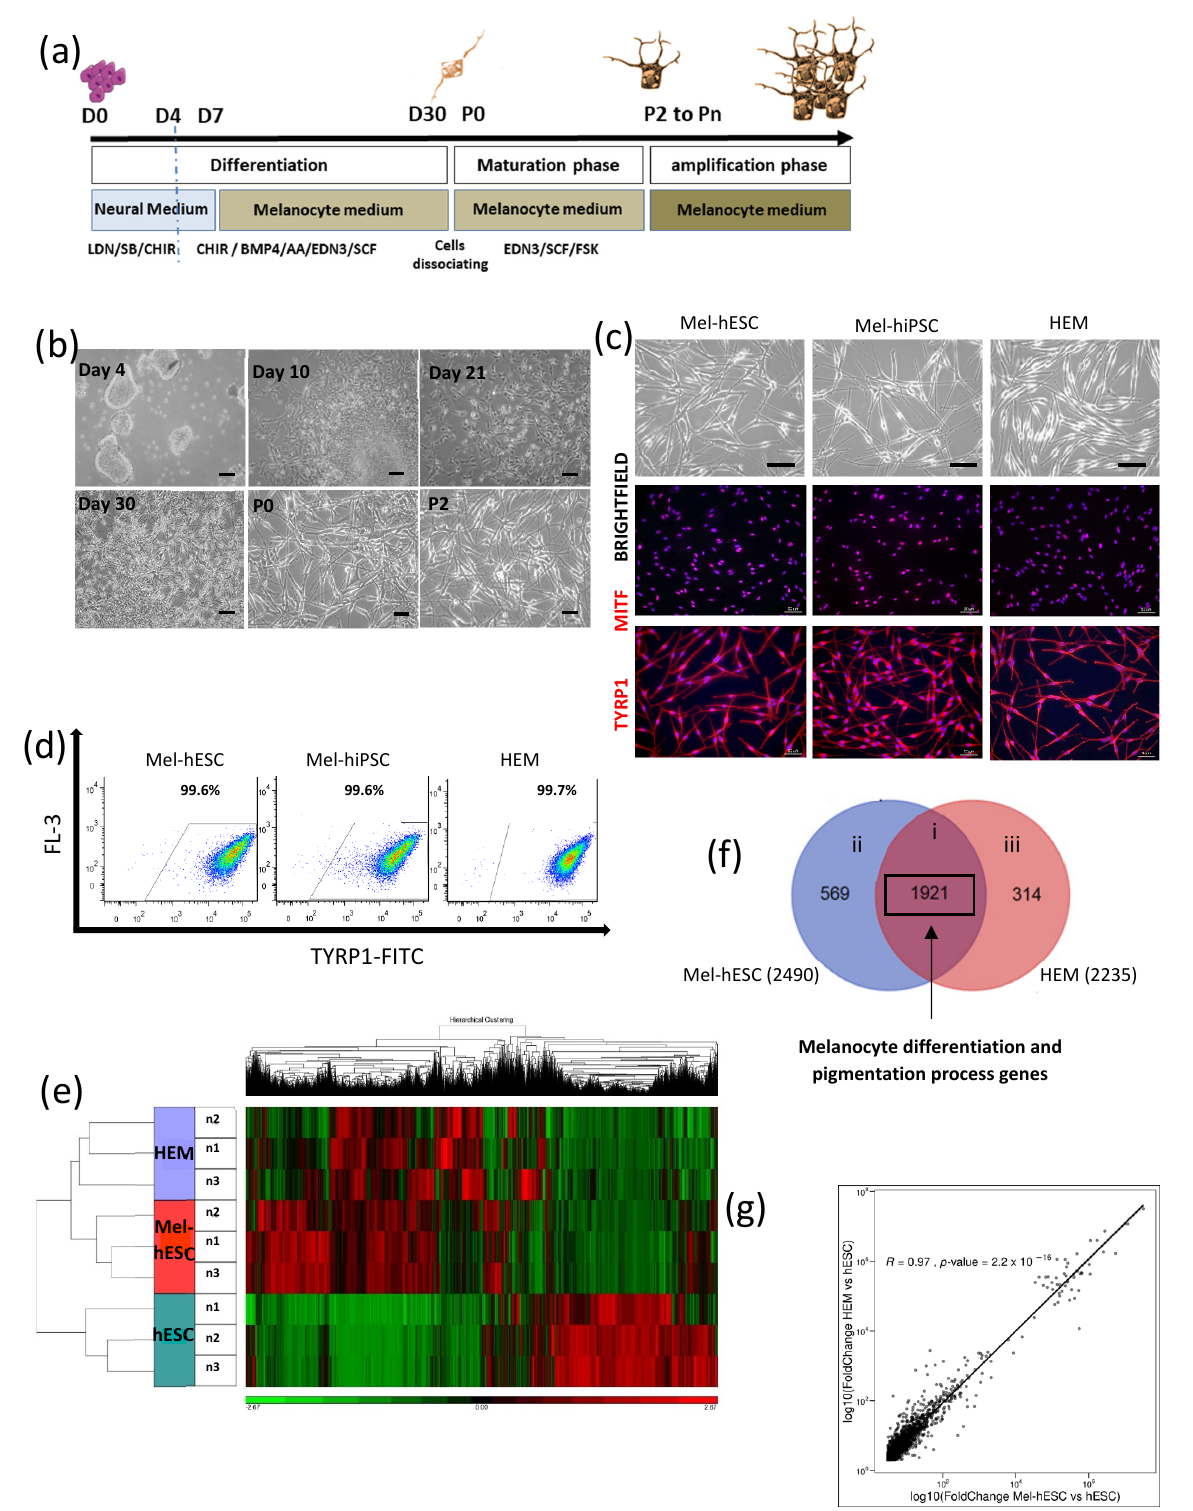
Figure 1. Characterization of hPSC-derived melanocytes. ( a ) Diagram of the melanocytic differentia- tion from hPSCs. Illustrated using Servier Medical Arts-SMART image bank. ( b ) Microscopy images at different stages of melanocytic differentiation from hPSCs (scale bar: 50 µ m). ( c ) Microscopy